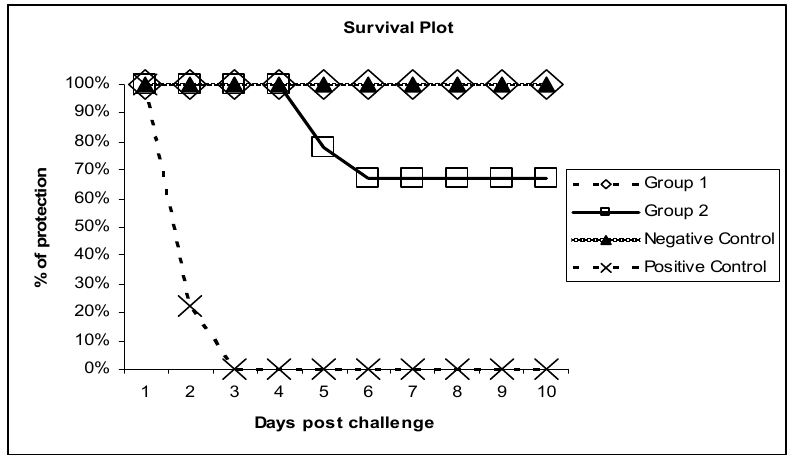
Figure 3. Survival plots indicating protection of H5N1 VLPs vaccinated chickens against HPAI H5N1 clade 2.2.1.2. The plot includes both groups of the current study, as well as the positive and negative control groups. Table 1. Immunogenicity and protection in the two groups of chickens after vaccination by VLPs without adjuvant by using distinct vaccination regiments, including the HI geometric mean titer in comparison to controls.